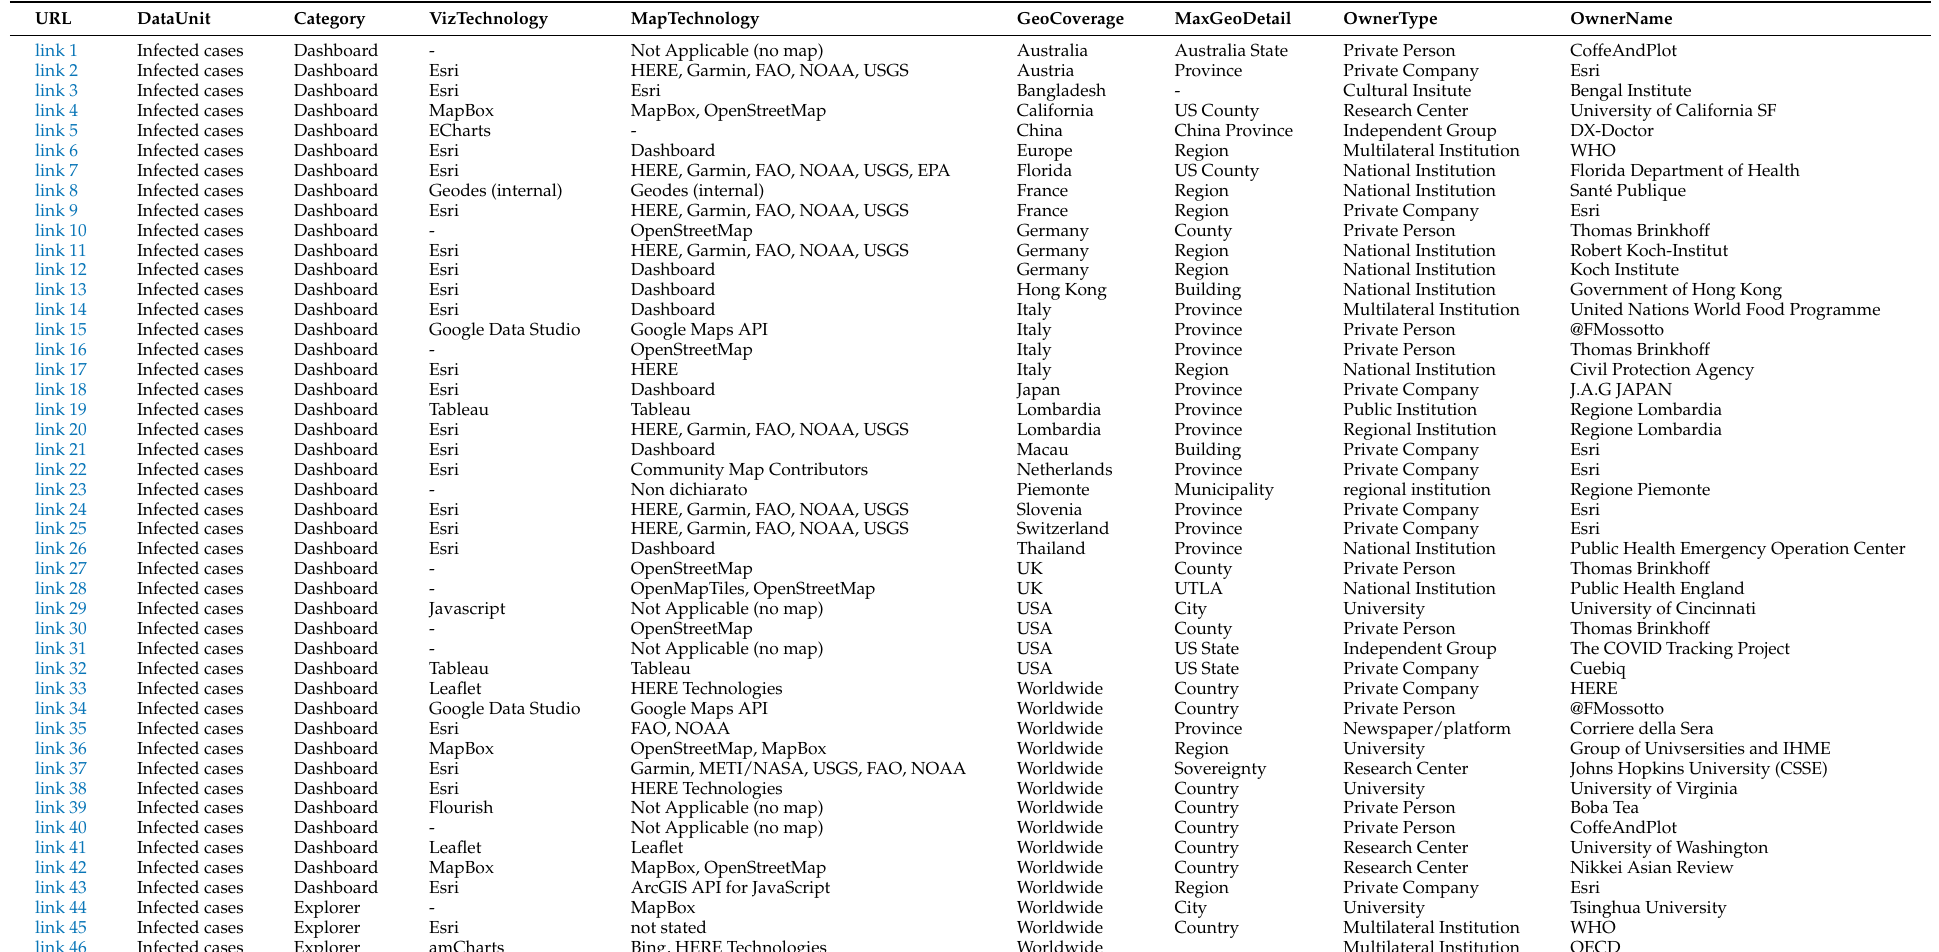
Table A1. A comprehensive list of analyzed resources, with their characterizing